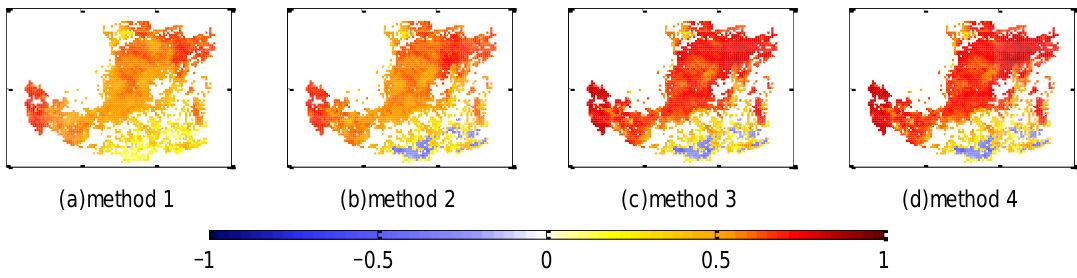
Figure 5. The correlation coefficient between NDVI and temperature was formulated by different time lag methods. The time-lag patterns detected by methods 2 to 4 are shown in Figures 6–8. Considering that method 2 only considers the effect of time lag, it can only reveal the time lag of the impact of precipitation and temperature on vegetation. The results are shown in Figure 6a,b, indicating that the time lag of the impact of precipitation and temperature are 0 or 1 month in arid and semi-arid areas, and 3 months in semi-humid areas. In addition to considering time lag, method 3 also considers the accumulation of precipitation and temperature effects on vegetation. Figure 7a,c show the time lag of precipitation and temperature effects, respectively, and Figure 7b,d show the accumulation of those effects, respectively. It can be seen that the time lag of precipitation and temperature are mainly 0 months, while the accumulation is mainly 1 or 2 months. In other words, method 3 reveals that the impact of precipitation and temperature mainly comes from the last 1 or 2 months. In contrast with methods 2 and 3, the proposed method (method 4) can obtain the impact weights of climate factors in the previous three months and the current month on the vegetation of the current month. Method 4 (Figure 8) provides the best weights per pixel for climate factors in different months by the highest R 2 , which cannot be detected by the other two methods. Figure 8a–d represent the impact weight combinations of (T − 3), (T − 2), (T − 1), and T months’ precipitation on T month’s NDVI, respectively, and Figure 8e–h represent the weight combinations of temperature, respectively. The weight combinations of the two climate factors are different, but the higher weights of both mainly concentrate in the last two months, where the average of the weights of precipitation and temperature in T month for all pixels are 0.51 and 0.53, respectively, and the average of the weights in (T − 1) month are 0.36 and 0.42, respectively.